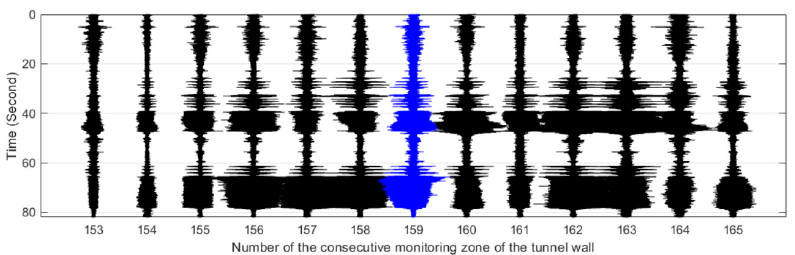
Figure 12. Distributed vibration responses of 13 consecutive monitoring zones under the perturbation of position P2.